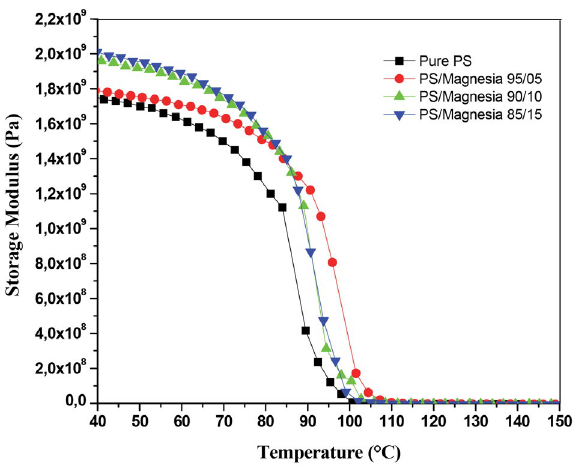
Figure 2: Storage modulus variations of pure PS and PS/Magnesia composites.